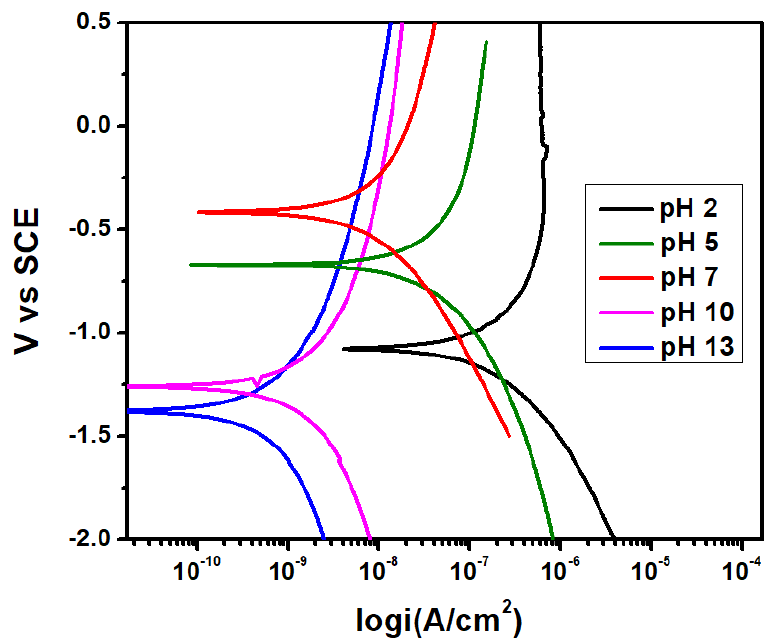
Figure 2. Poltentiodynamic polarization curve of laser welded duplex 2205 stainless-steel at different pH solution.